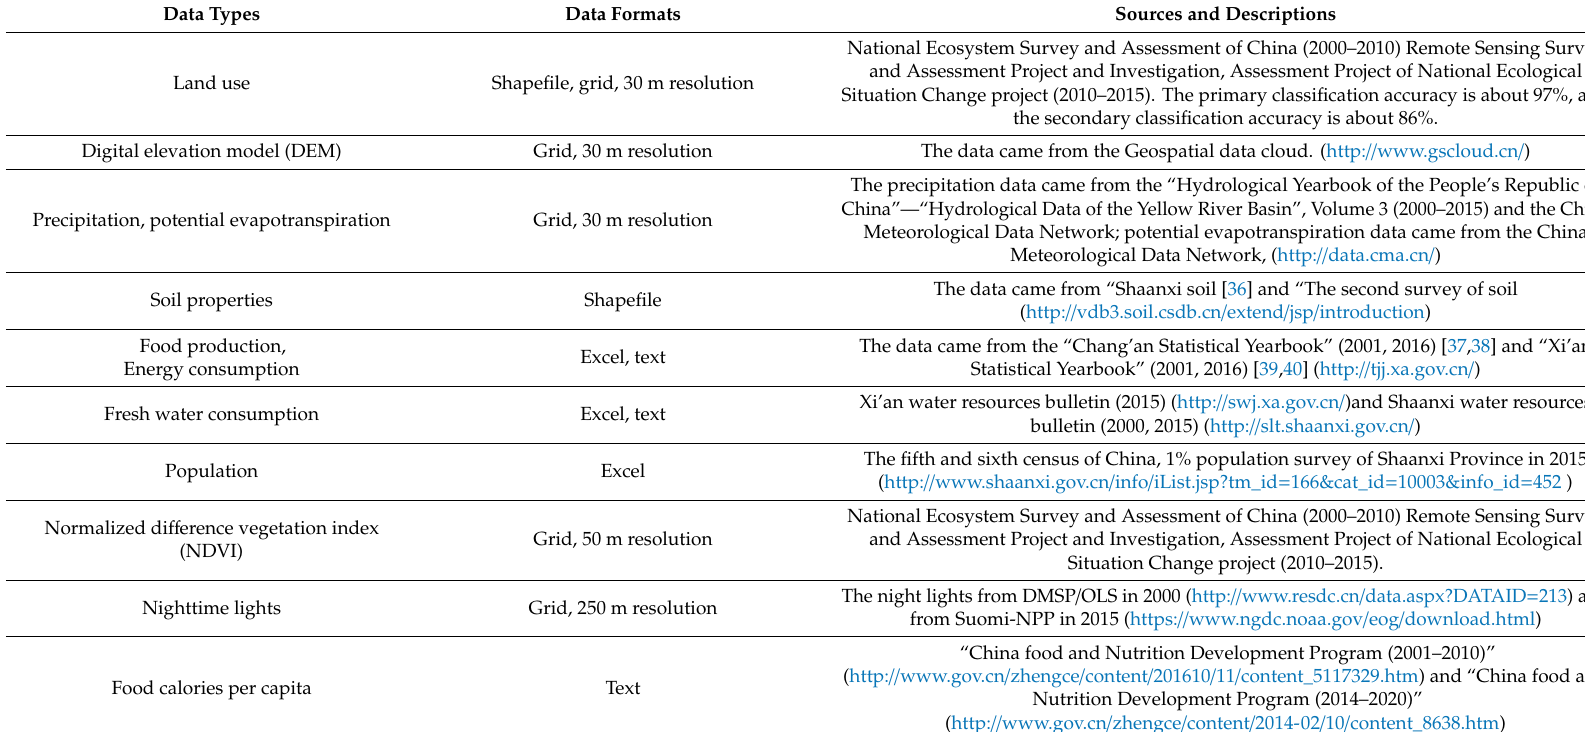
Table 1. The data sources mapped by the supply and demand of ecosystem services